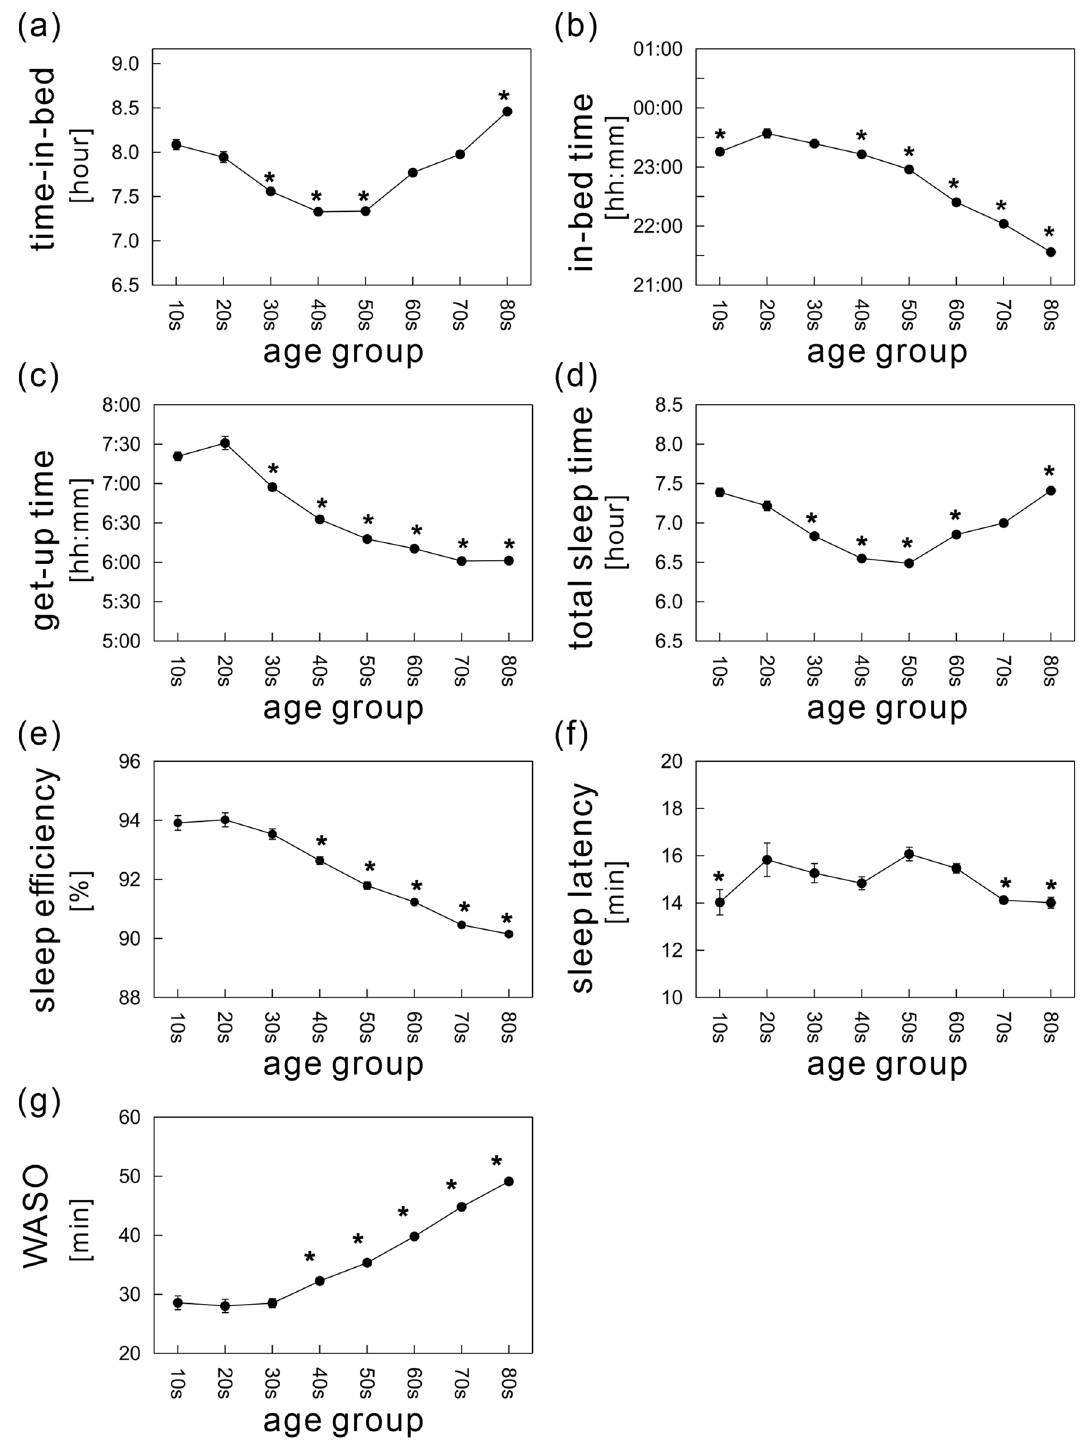
Figure 2. Age-dependent differences in sleep parameters: ( a ) time-in-bed (TIB), ( b ) in-bed time, ( c ) get-up time, ( d ) total sleep time, ( e ) sleep efficiency, ( f ) sleep latency, and ( g ) wake time after sleep onset (WASO). The mean values of each sleep parameter are shown as a function of age, ranging from age 10 to 89 years divided into eight age groups with 10-year intervals (solid black circles). The error bars indicate the standard error of the mean. *Indicates significance relative to the 20s age group ( p <